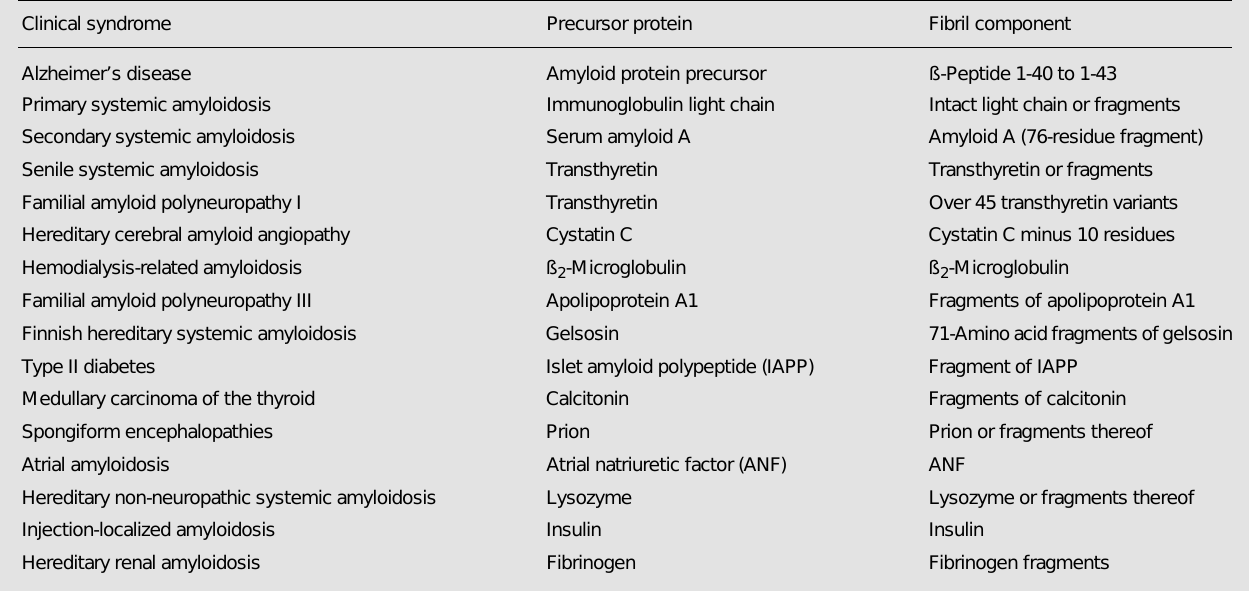
Table 1 - Amyloidogenic proteins and the corresponding diseases (according to Kelly (55)). Clinical